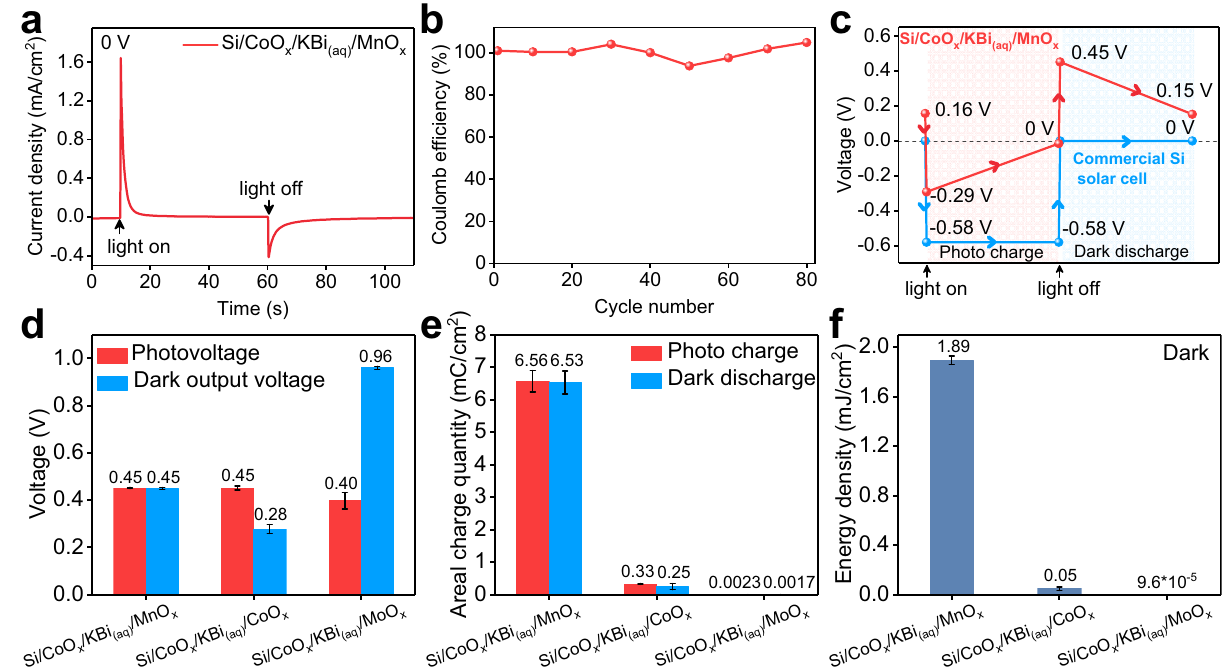
Fig. 2 Photoelectrochemical properties of Faradaic junction devices. a I – t curve during photo charge and dark discharge under zero bias of the Si/CoO x / KBi (aq) /MnO x device. b Coulomb ef fi ciency of the Si/CoO x /KBi (aq) /MnO x device during photo charge and dark discharge cycles. c Open circuit voltages of the Si/CoO x /KBi (aq) /MnO x Faradaic junction device and a commercial Si solar cell, and the photo charge and dark discharge were carried out in the Faradaic junction device by i-t curves without bias. d Photovoltages and dark output voltages of Si/CoO x /KBi (aq) /MnO x , Si/CoO x /KBi (aq) /CoO x and Si/ CoO x /KBi (aq) /MoO x devices. e Areal charge quantities of photo charge and dark discharge in the three devices. f Dark output energy density of the three devices. The results in Fig. 2d – f show average values with the standard deviation as the error bar. Light source: 1 Sun of simulated solar illumination by a Xe lamp with AM 1.5 G fi lter (100 mW cm − 2 ), electrolyte: KBi aqueous solution (0.2 M KOH and 0.4 M H 3 BO 3 ) with pH =